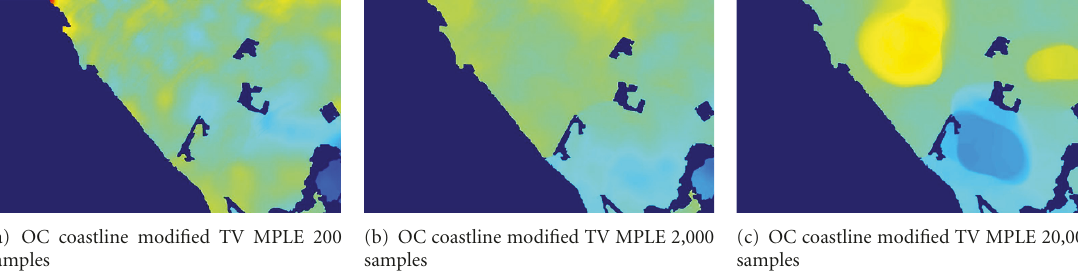
Figure 8: These images are the Modified TV MPLE estimates for 200, 2,000, and 20,000 sampled events of the Orange County Coastline example. The color scale for these images is located in Figure 5.